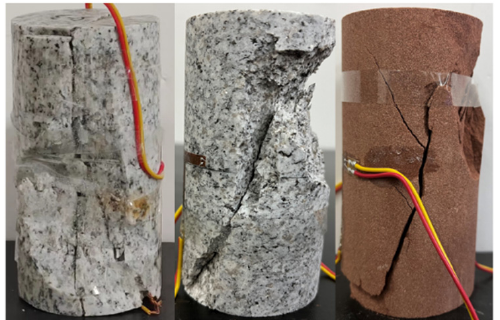
Figure 5. Images of uniaxial compression damage in the three rock samples.